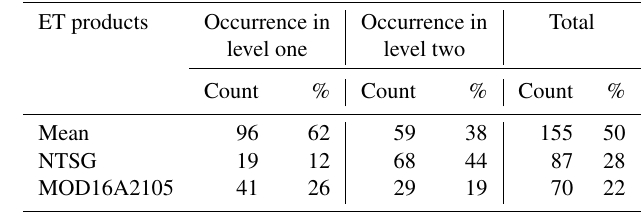
Table 9. The occurrence of NTSG and MOD16A2105 products and their ensemble mean during 2001 and